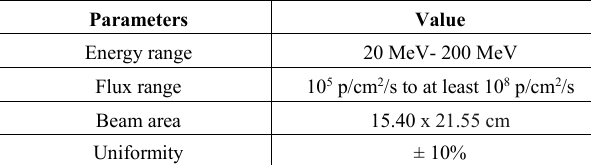
TABLE I. The requirements of ESA/ESCC No: 25100 Standard for SEE tests.